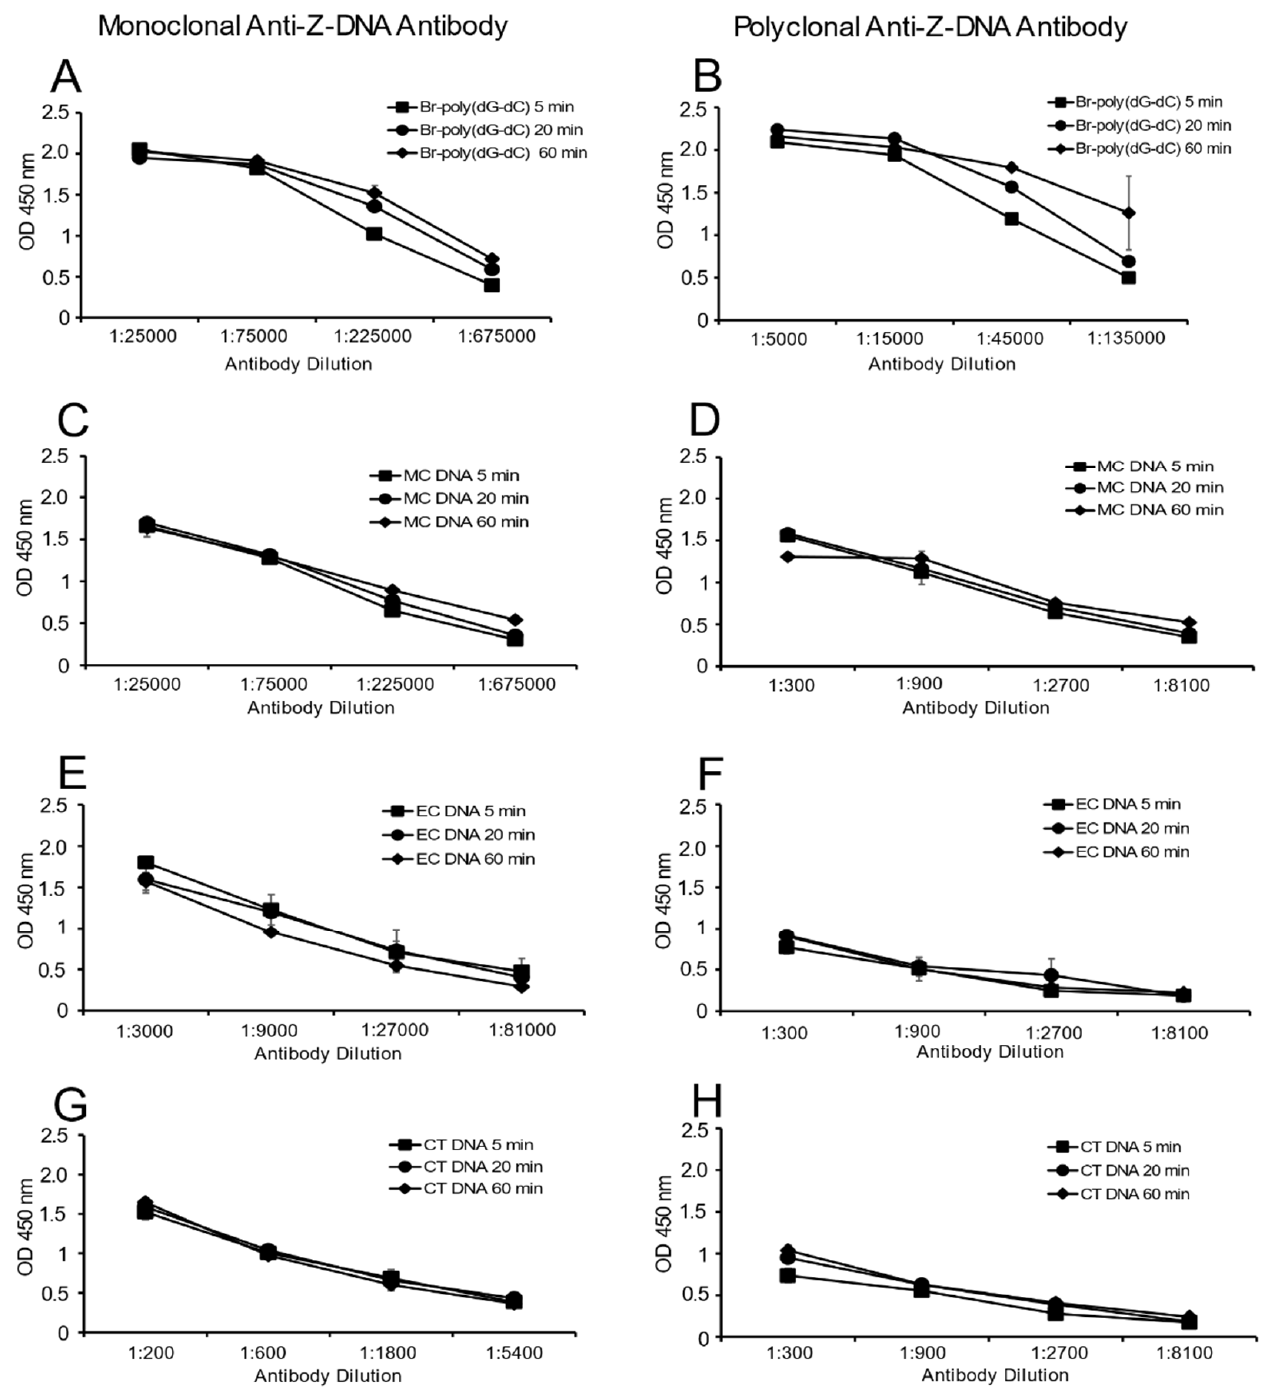
Figure 5. Time course of antibody binding to natural DNA and Br-poly(dG-dC). The binding of monoclonal and polyclonal anti-Z-DNA antibodies to natural DNA (MC and EC) and Br-poly(dG-dC) was tested at 5, 20 and 60 min. ( A , C , E , G ) Results of monoclonal anti-Z-DNA binding; ( B , D , F , H ) polyclonal anti-Z-DNA binding. DNA was coated to plates at 2 µ g/mL. Antibody preparations were titered, with the starting concentrations determined by a prior experiment to determine the dilutions covering the linear portion of antibody binding to DNA. Results are presented as the average OD 450 nm values of duplicate wells. Means and standard deviations are shown.